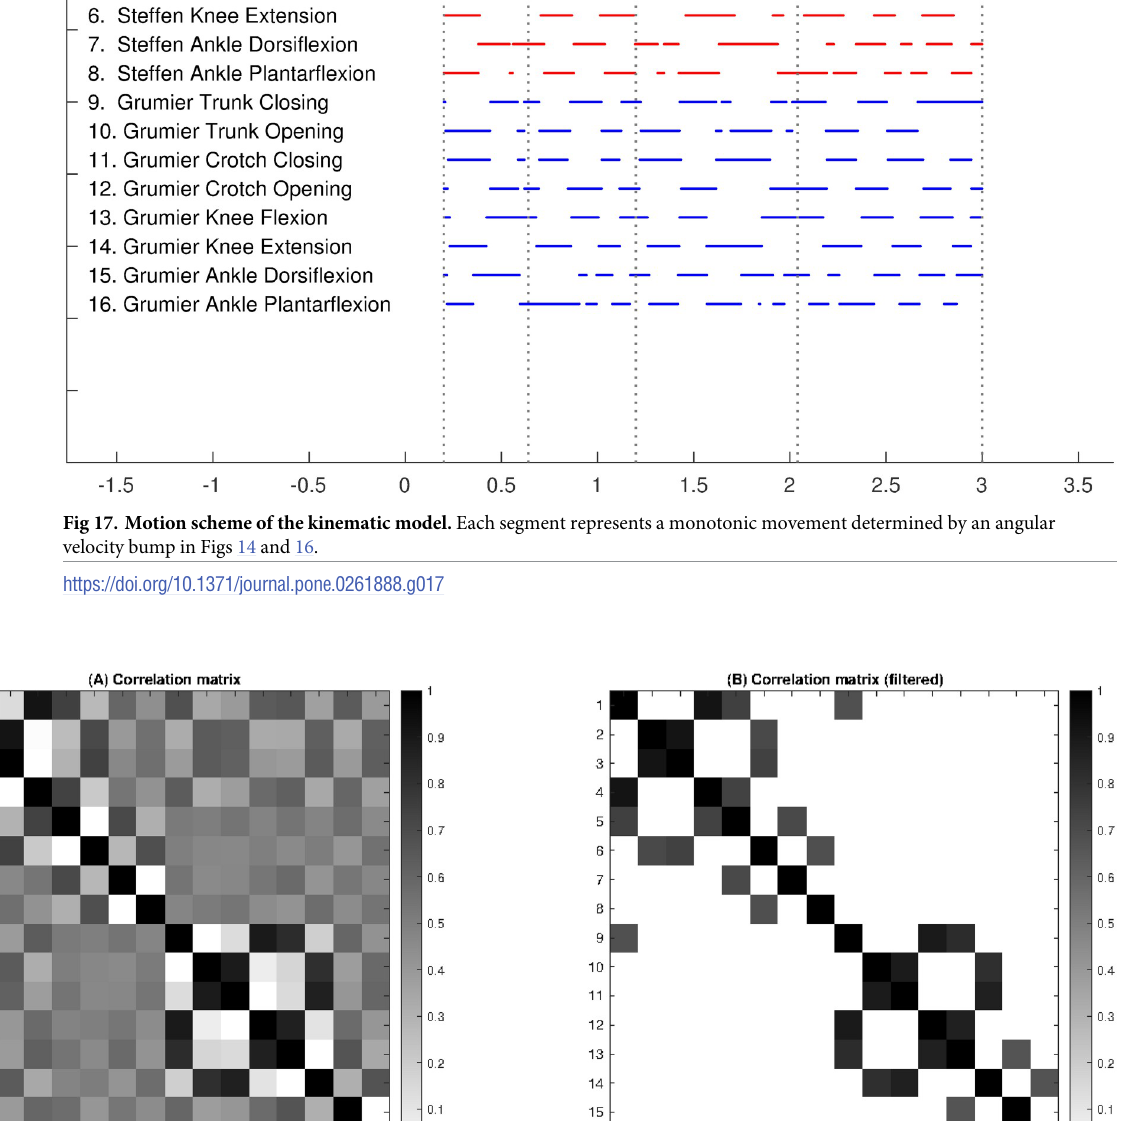
measures the correlation between rows i and j in the ij